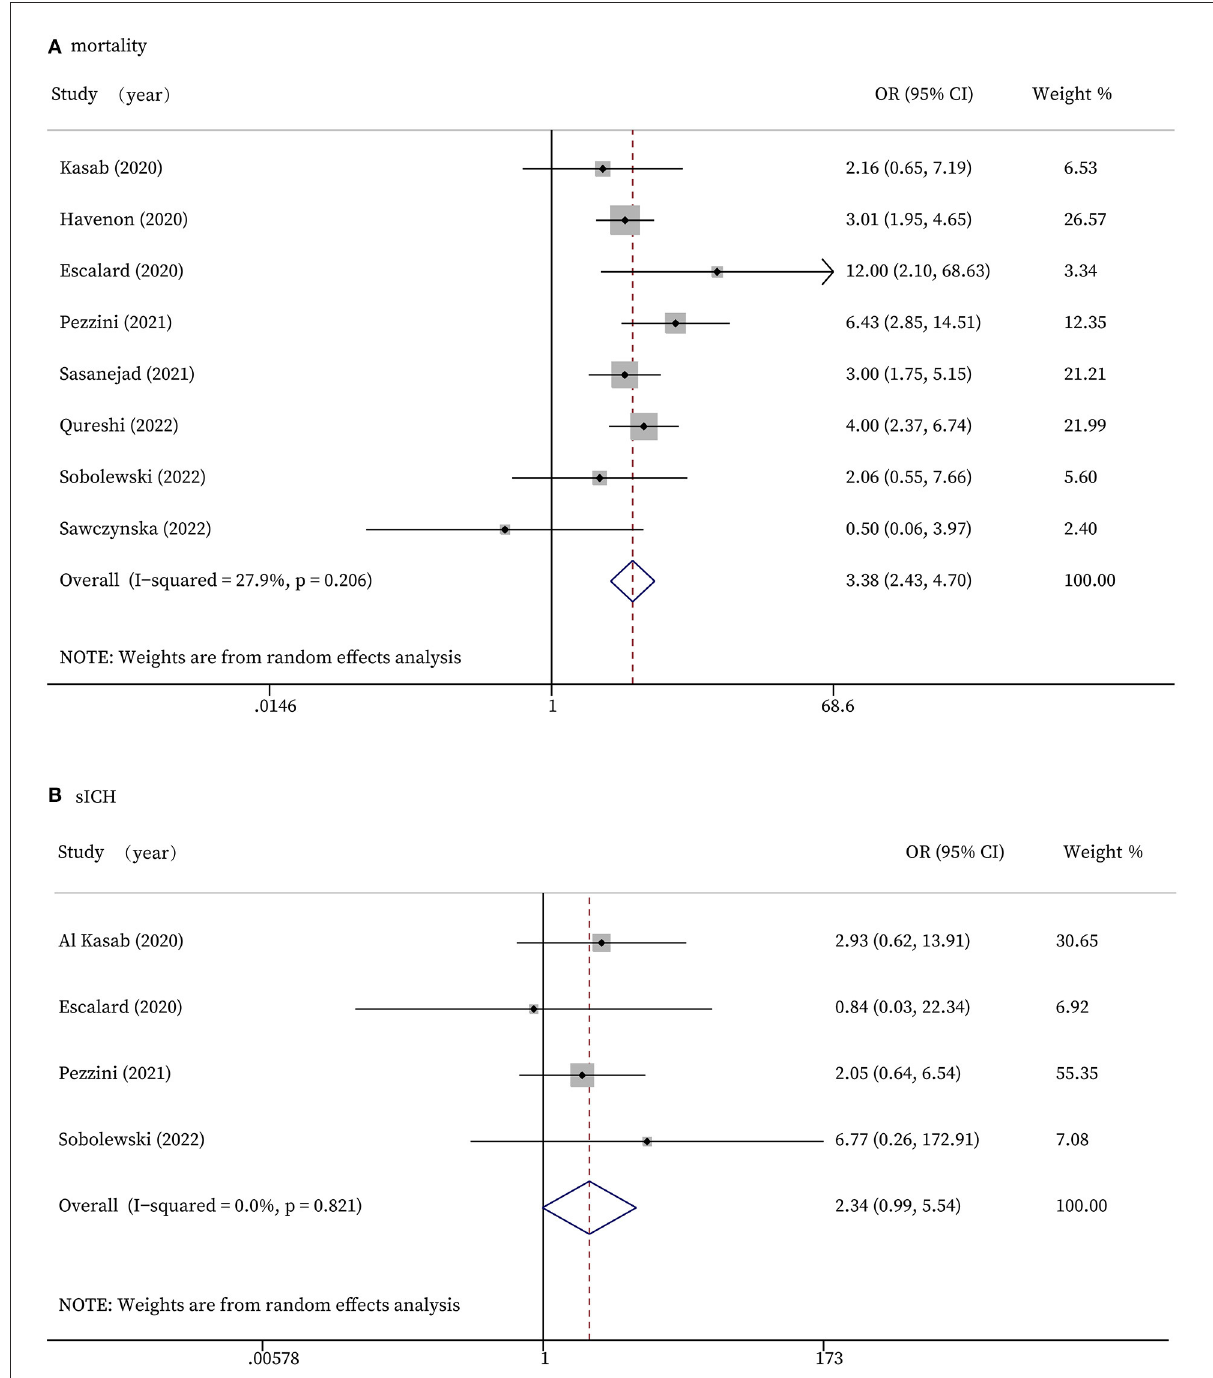
FIGURE3 Forest plots for safety outcomes. (A) : In-hospital mortality; (B) : Symptomatic intracranial hemorrhage.